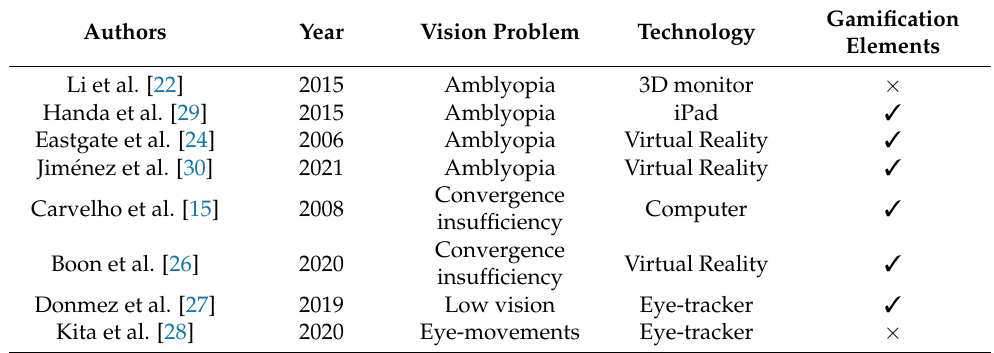
Table 1. Literature for vision therapy supported by technologies with ( (cid:51) ) or without ( × ) gamification